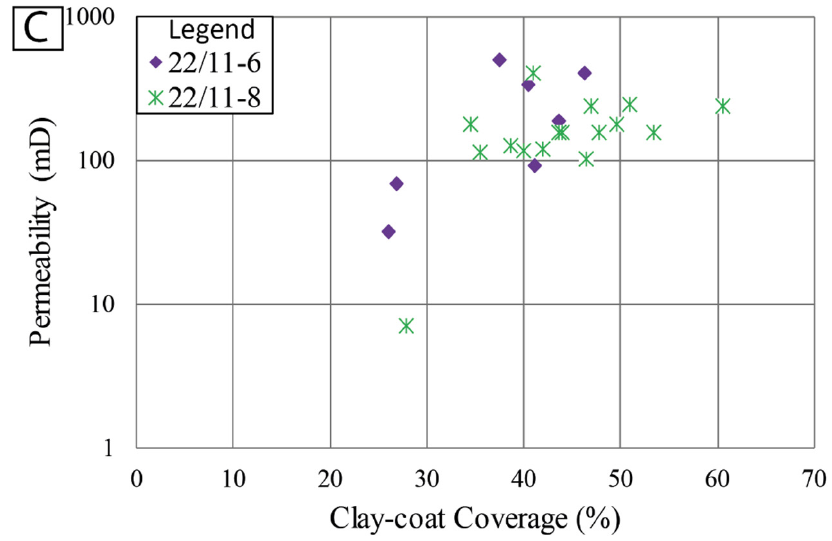
Figure 14. Role of grain-coating clays coverage on quartz cement and reservoir properties. ( A ) Plot of quartz cement volume against clay-coating coverage. ( B ) Plot of porosity against clay-coating coverage. ( C ) Plot of permeability against clay-coating coverage.